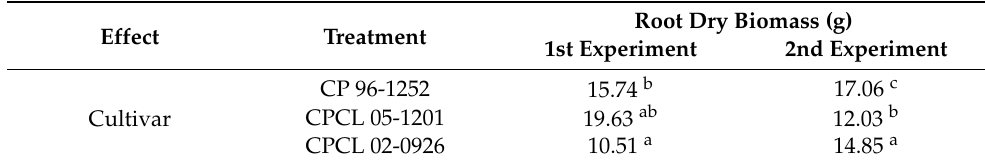
Table 8. Root dry biomass in different sugarcane cultivars in first and second greenhouse experiments a